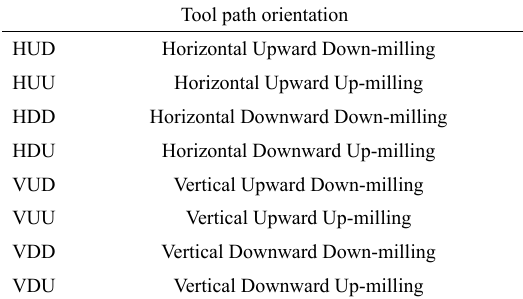
Table 1. Description of tool path orientations employed